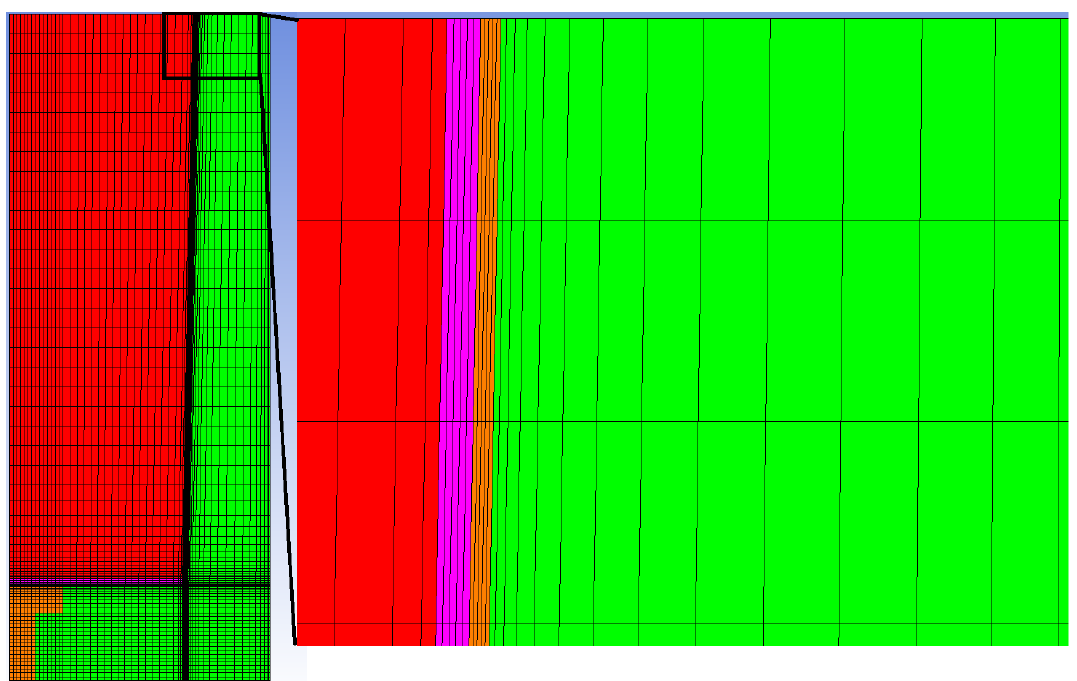
Figure A3. Heat transfer coefficient as a function of air velocity and drum position.